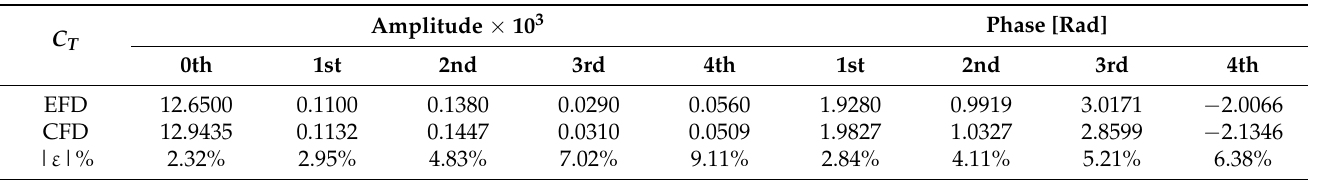
Table 9. Harmonic amplitudes and phases of the total resistance coefficient ( C T ) for the FRxz ϕθ bow waves